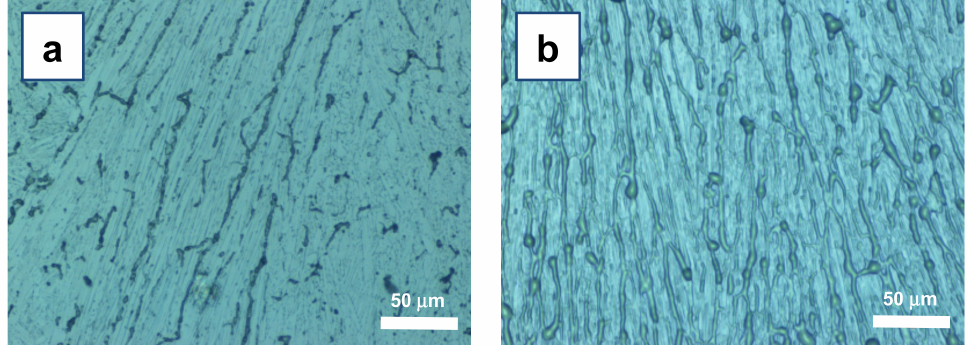
Figure 2. Morphologies of PLGA nanofibers developed using ( a ) low polymer concentrations (sample M400) or ( b ) high polymer concentrations (sample M50). It is possible to appreciate that at low PLGA concentrations, the fibers (dark lines over light blue background) are sparse, often with small lateral size and frequently disrupted, while at high PLGA concentrations, the fibers tend to be overlapped with neighboring ones and to have a large lateral